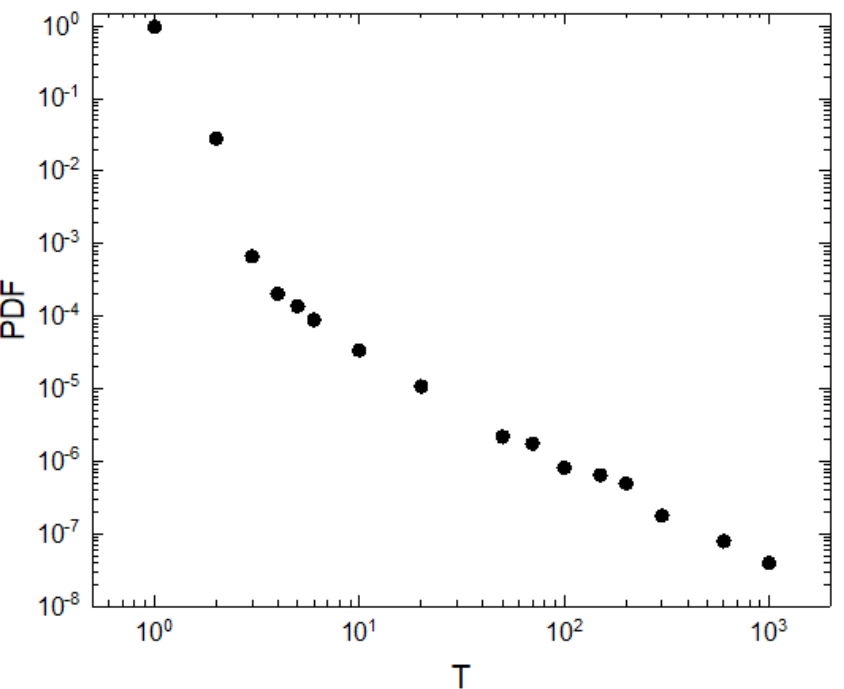
Figure 6. Probability density function of the inter-event times of consecutive interactions between a single animal and any receiver station for the case of 100 receiver stations. Both axes are shown in logarithmic scale. We show results averaged over 100 realizations, 100,000 time steps were considered, v = 0.001, r = 0.01 and a = 0.001.